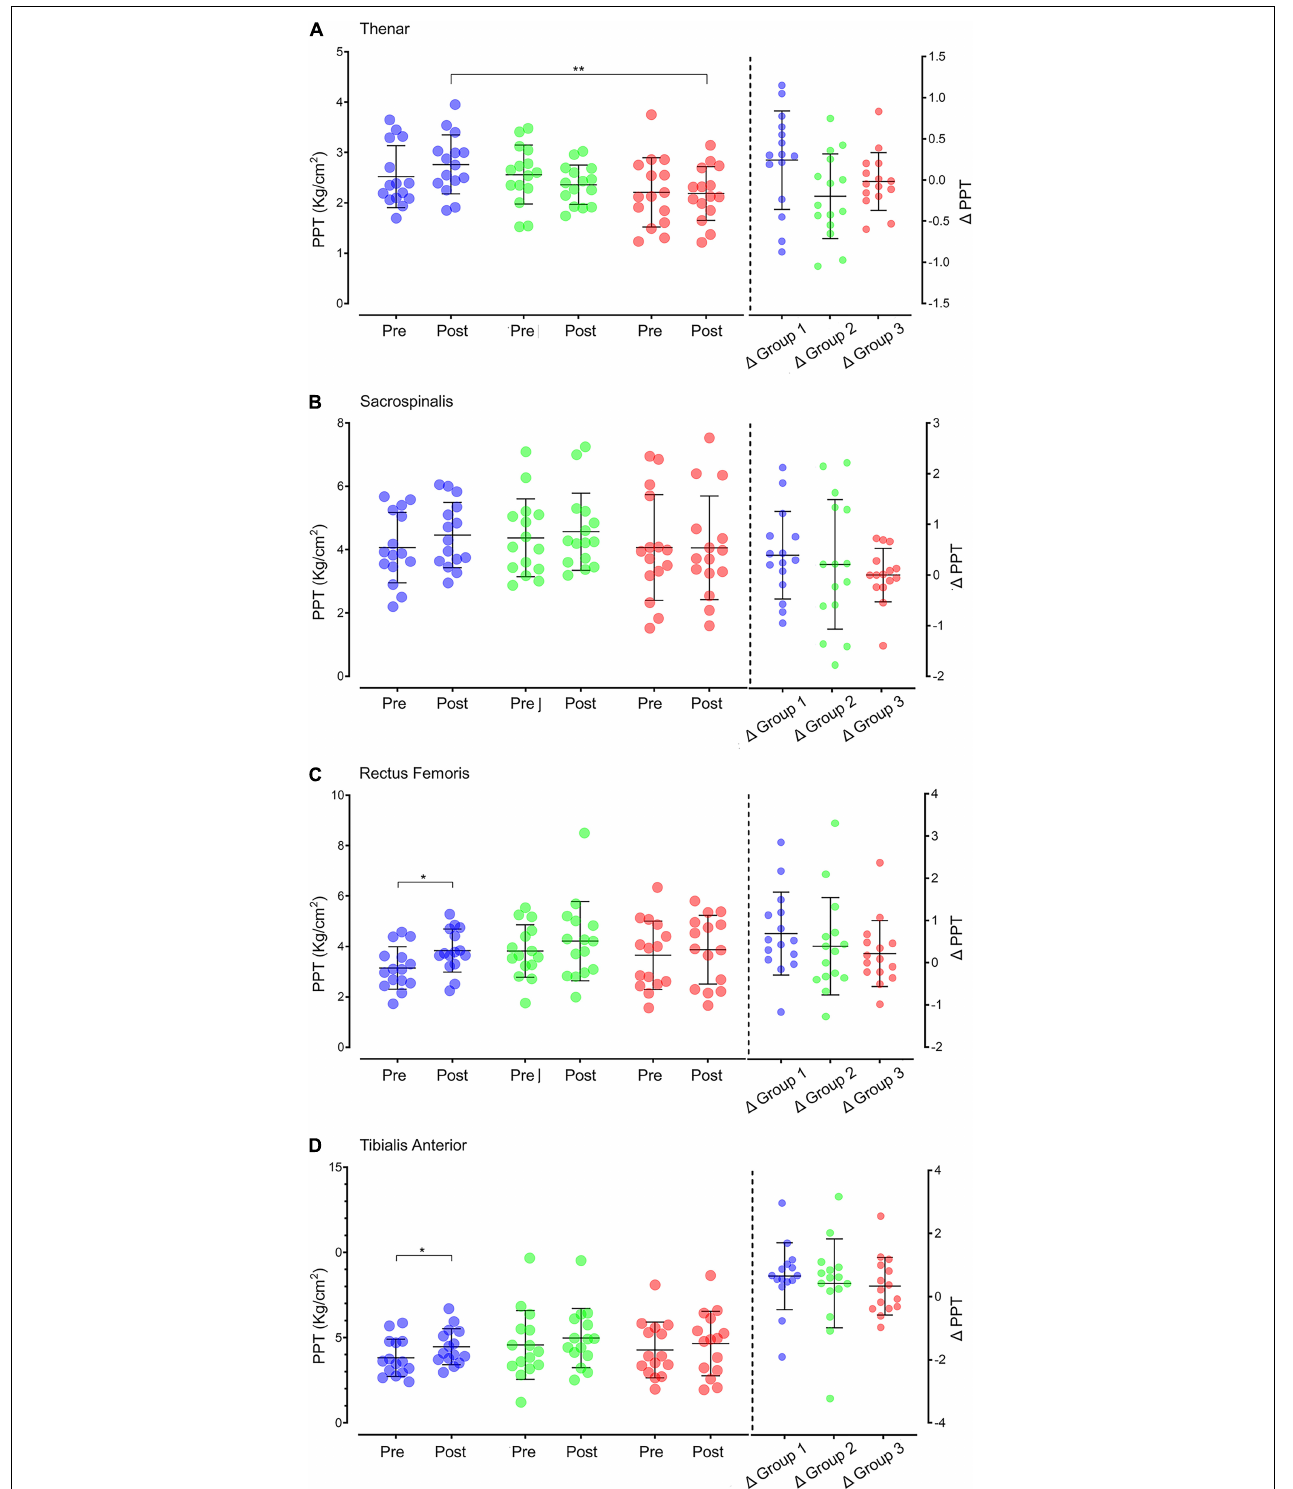
FIGURE 2 | PPT in different sites before and after intervention in the three groups. (A) Thenar muscle PPT. (B) Sacrospinalis PPT. (C) Rectus femoris PPT. (D) Tibialis anterior PPT. On the left of the vertical dotted line are the PPT values before and after intervention of individuals (dots: purple for Group 1, green for Group 2, and red for Group 3) and groups (black line: X ± SD). The data on the right of the vertical dotted line are the individual (dot) and group (black line: X ± SD) values of the difference in PPT after intervention ( (cid:77) = posttest–pretest). PPT: pressure pain threshold; Pre: pretest; Post: posttest. * p < 0.05; ** p < 0.01.